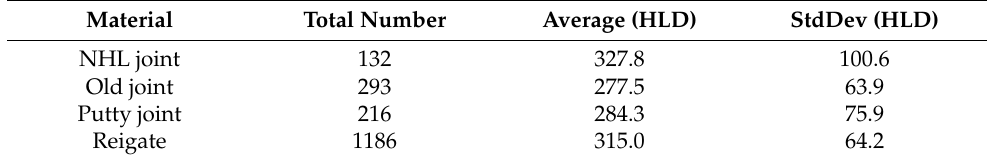
Table 5. Total number of surface hardness measurements on different materials, average measure- ment value, and standard deviation in HLD across survey dates and locations depicted in Figure